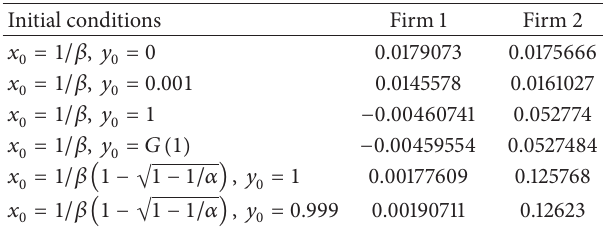
Table 1: We compute average profits for the initial conditions con- sidered in Figure 11 and following the iteration processes we make there we check that both firms should produce starting from the ini- tial conditions on the basis of the attractor (𝑓) . Note that the profits in the fixed point (Cournot equilibrium) are 0.0140236 for firm 1 and 0.148848 for firm 2, and therefore, the only firm interested in stabilizing the Cournot point will be firm